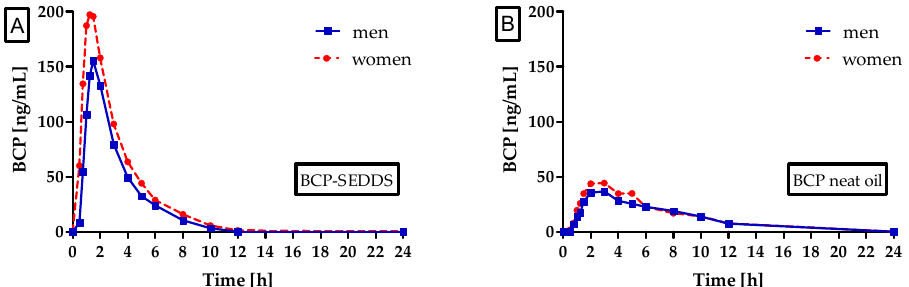
Figure 2. Beta-caryophyllene (BCP) plasma concentration time profile after a single oral dose of 100 mg BCP administered as self-emulsifying drug delivery system (BCP-SEDDS) ( A ) and BCP neat oil ( B ) depicted as summary curves of mean values at single time points for men (blue, solid line) and women (red, dotted line).